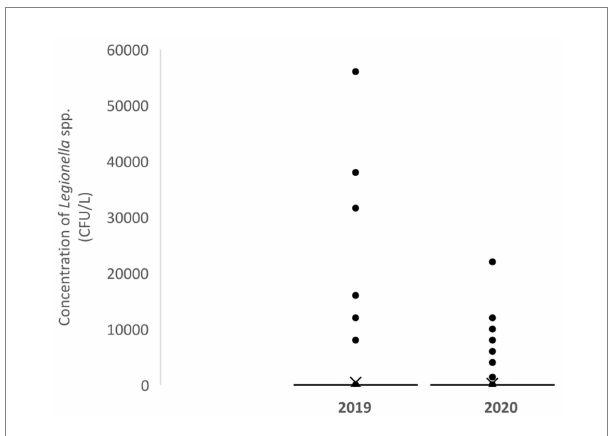
FIGURE 1 Box plot of Legionella spp. concentrations (CFU/L) in 2019 and